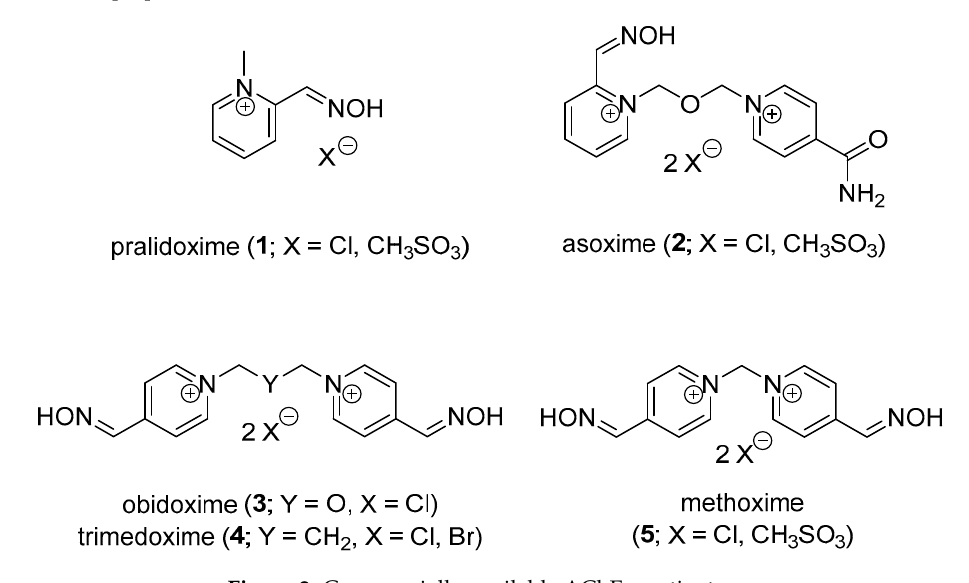
Figure 2. Commercially available AChE reactivators.